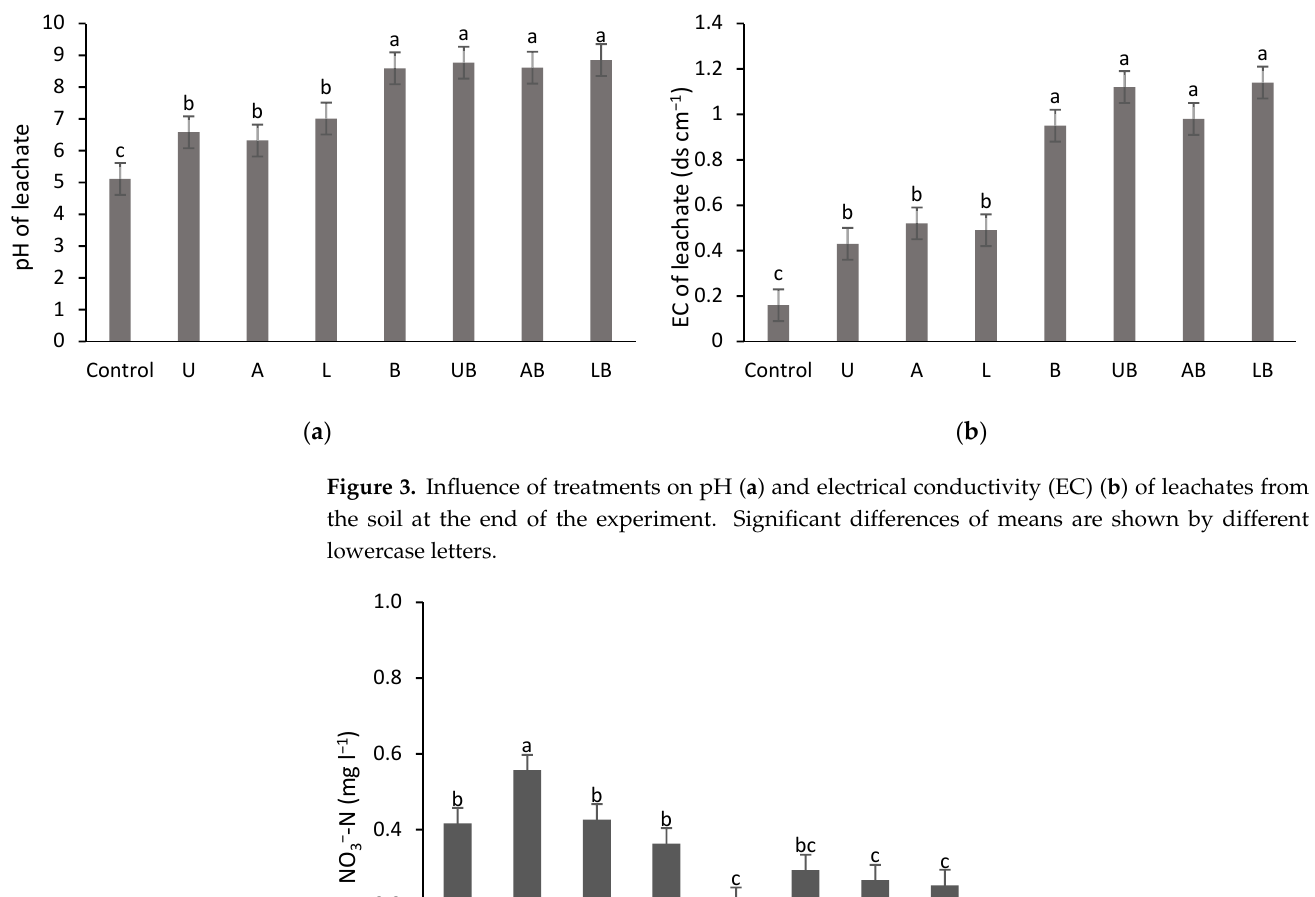
Figure 4. Changes in nitrate leaching status with applying different N-source treatments. Signifi- cant differences of means are shown by different lowercase letters.